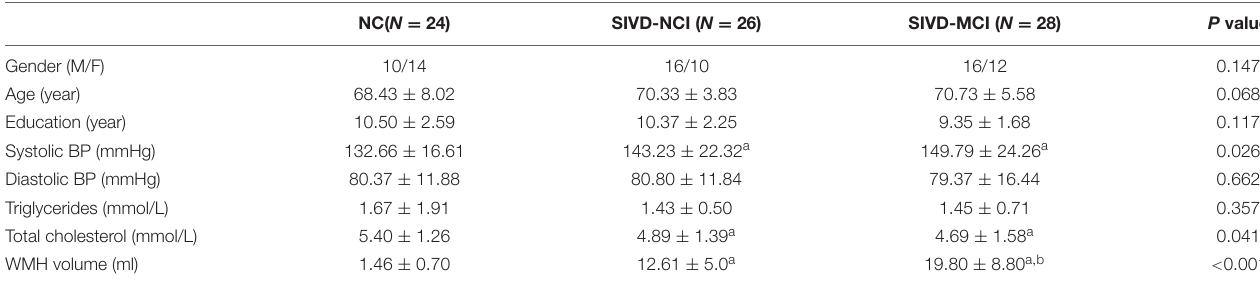
TABLE 1 | Demographic and clinical characteristics of the